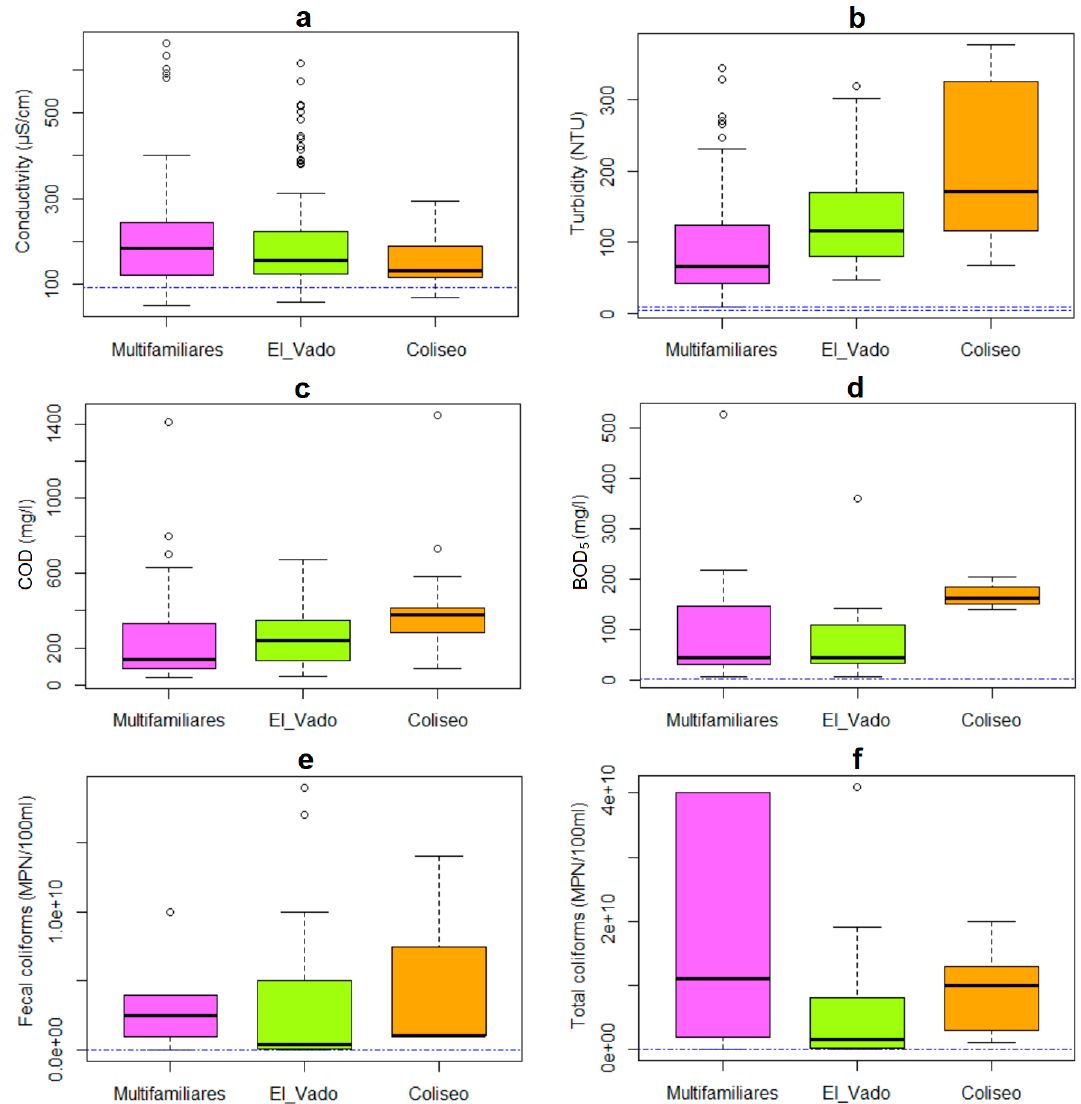
Figure 3. Analysis of the samples collected in the three CSOs throughout the study period of 2017–2018. ( a ) Conductivity; ( b ) turbidity; ( c ) chemical oxygen demand; ( d ) five-day biochemical oxygen demand; ( e ) fecal coliforms; ( f ) total coliforms. The blue dot and dash line represent the values recorder in the Tomebamba River in the rainy season [24].